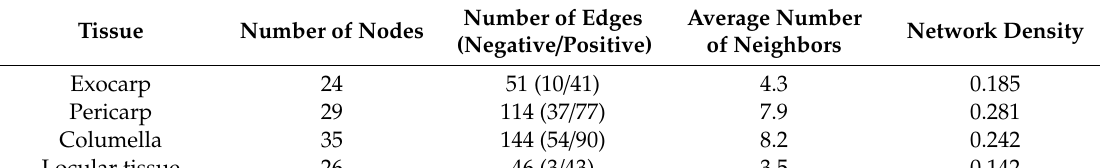
Table 1. Parameters of the correlation networks for four tomato fruit tissues based on the absolute contents of 39 metabolites and starch along fruit development measured by 1 H-NMR, LC-DAD, or